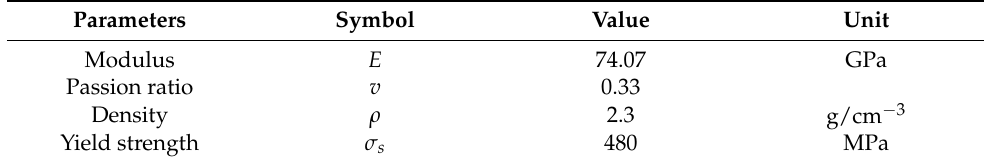
Table 3. Elastic parameters of Al7075.